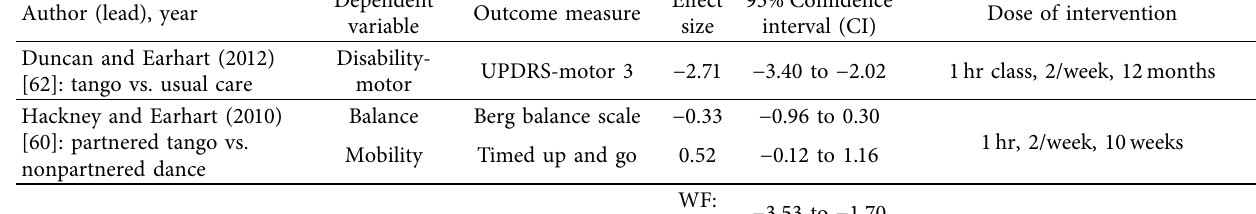
Table 4: Data analysis for randomised controlled